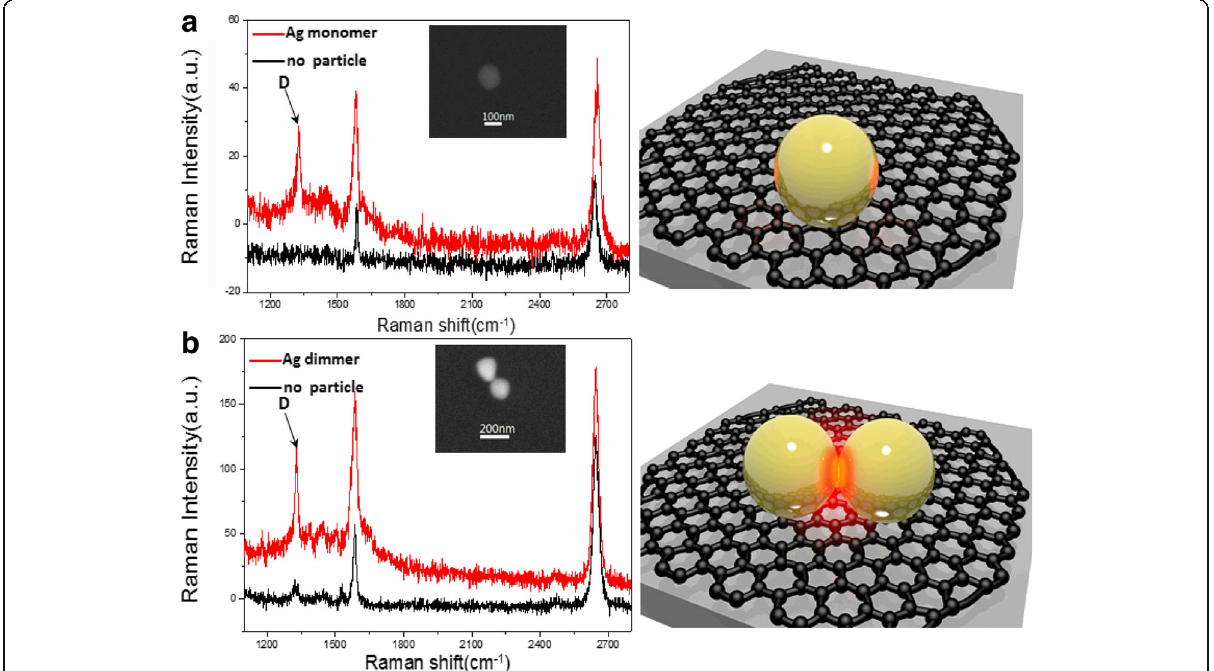
Fig. 3 SERS of nanoparticle/graphene hybrid system. a SERS of monolayer graphene adsorbed on graphene from Ag nanoparticle monomer and without particle and scheme of the samples. b SERS of monolayer graphene adsorbed on graphene from Ag nanoparticle dimer and without particle and scheme of the